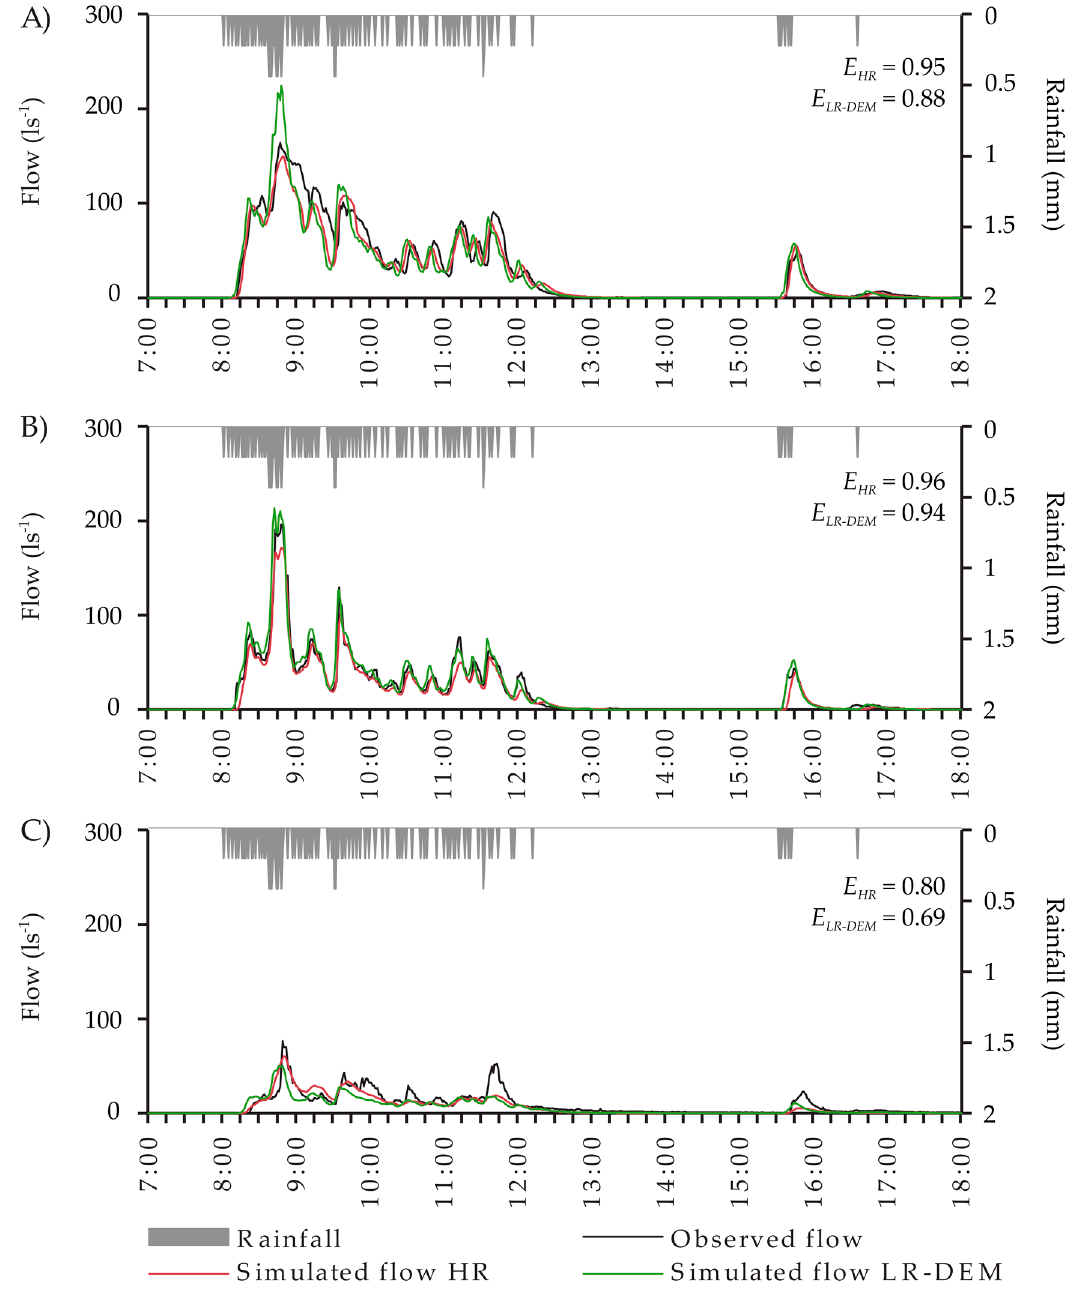
Figure 3. Observed and simulated (HR and LR ‐ DEM) flow for ( A ) Catchment 1; ( B ) Catchment 2; and ( C ) Catchment 3, and the model efficiency E (event rainfall depth 22.0 mm, peak intensity 1.73 mm/5 min).